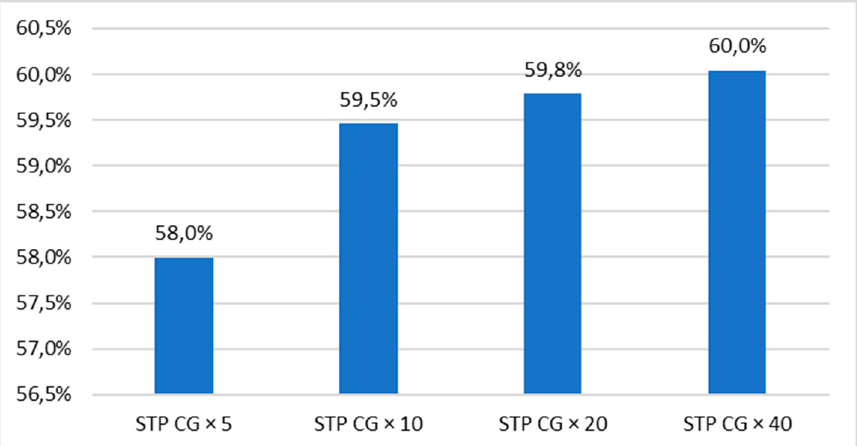
Figure 9. The average power savings per task for the architecture with clock-gating mechanism compared with the appropriate STP structure for the number of tasks (cores).